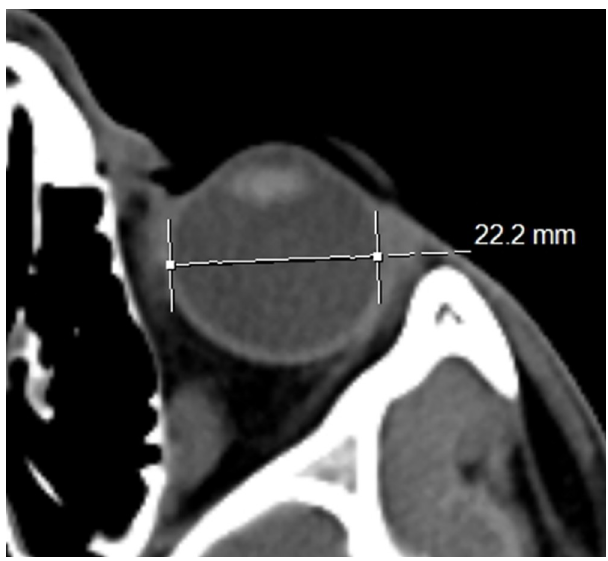
Fig 3. ETD measurement in the same patient as in Fig 1. ETD is measured from retina to retina on axial images. Usually the largest ETD and the ONSD are located in different horizontal planes and are measured on different